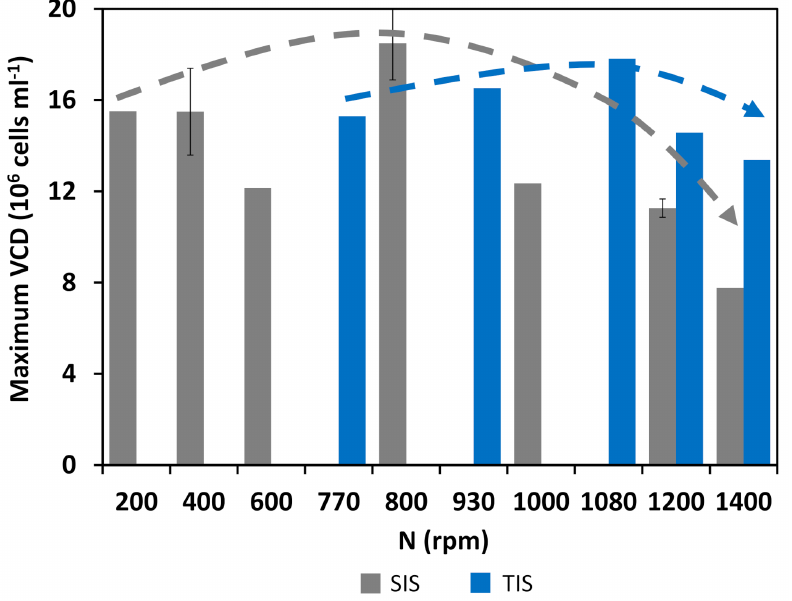
Figure 5. Maximum viable cell densities (VCD) compared for experiments in both reactor setups: cultivation results from the SIS (grey bars); cultivation results from the TIS (blue bars). Data for 400, 800, and 1200 rpm in the SIS were averaged from three cultivations each. Dashed arrows indicate qualitative trends for each reactor